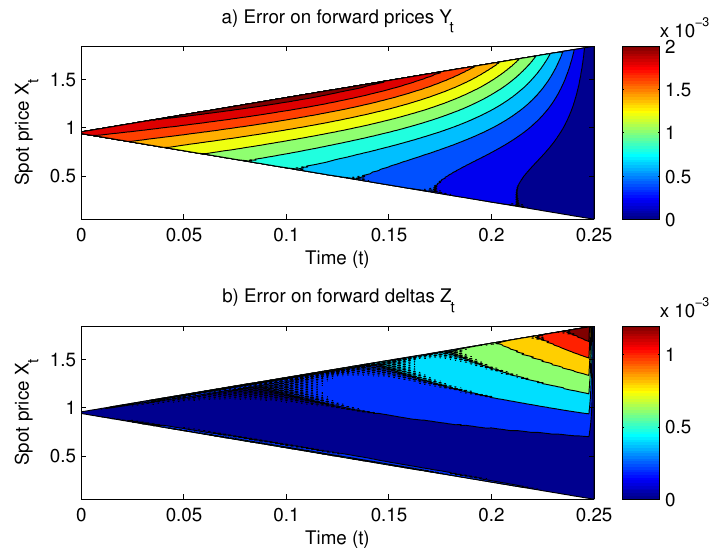
Figure 7. Errors using the 2-stage Runge–Kutta scheme with κ = 3. The numerical solution is obtained on a time mesh with n = 100 time steps and returns an forward price of 1.0238 and initial value of 0.0316 for the control process. The exact values are 1.0257 and 0.0315,